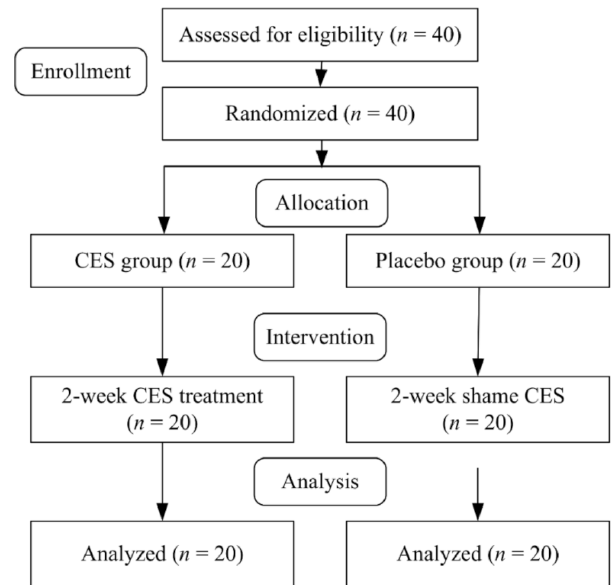
Figure 1. Study flow